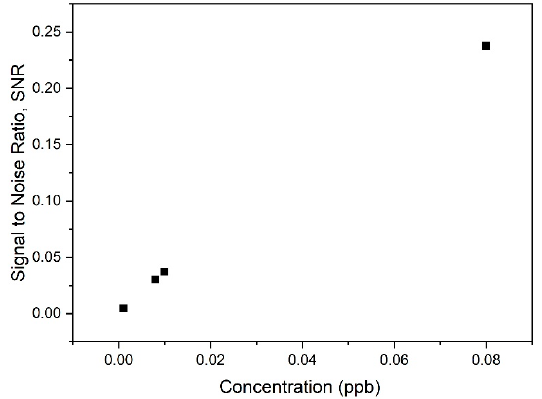
Figure 17. Graph of SNR versus carbaryl concentration.